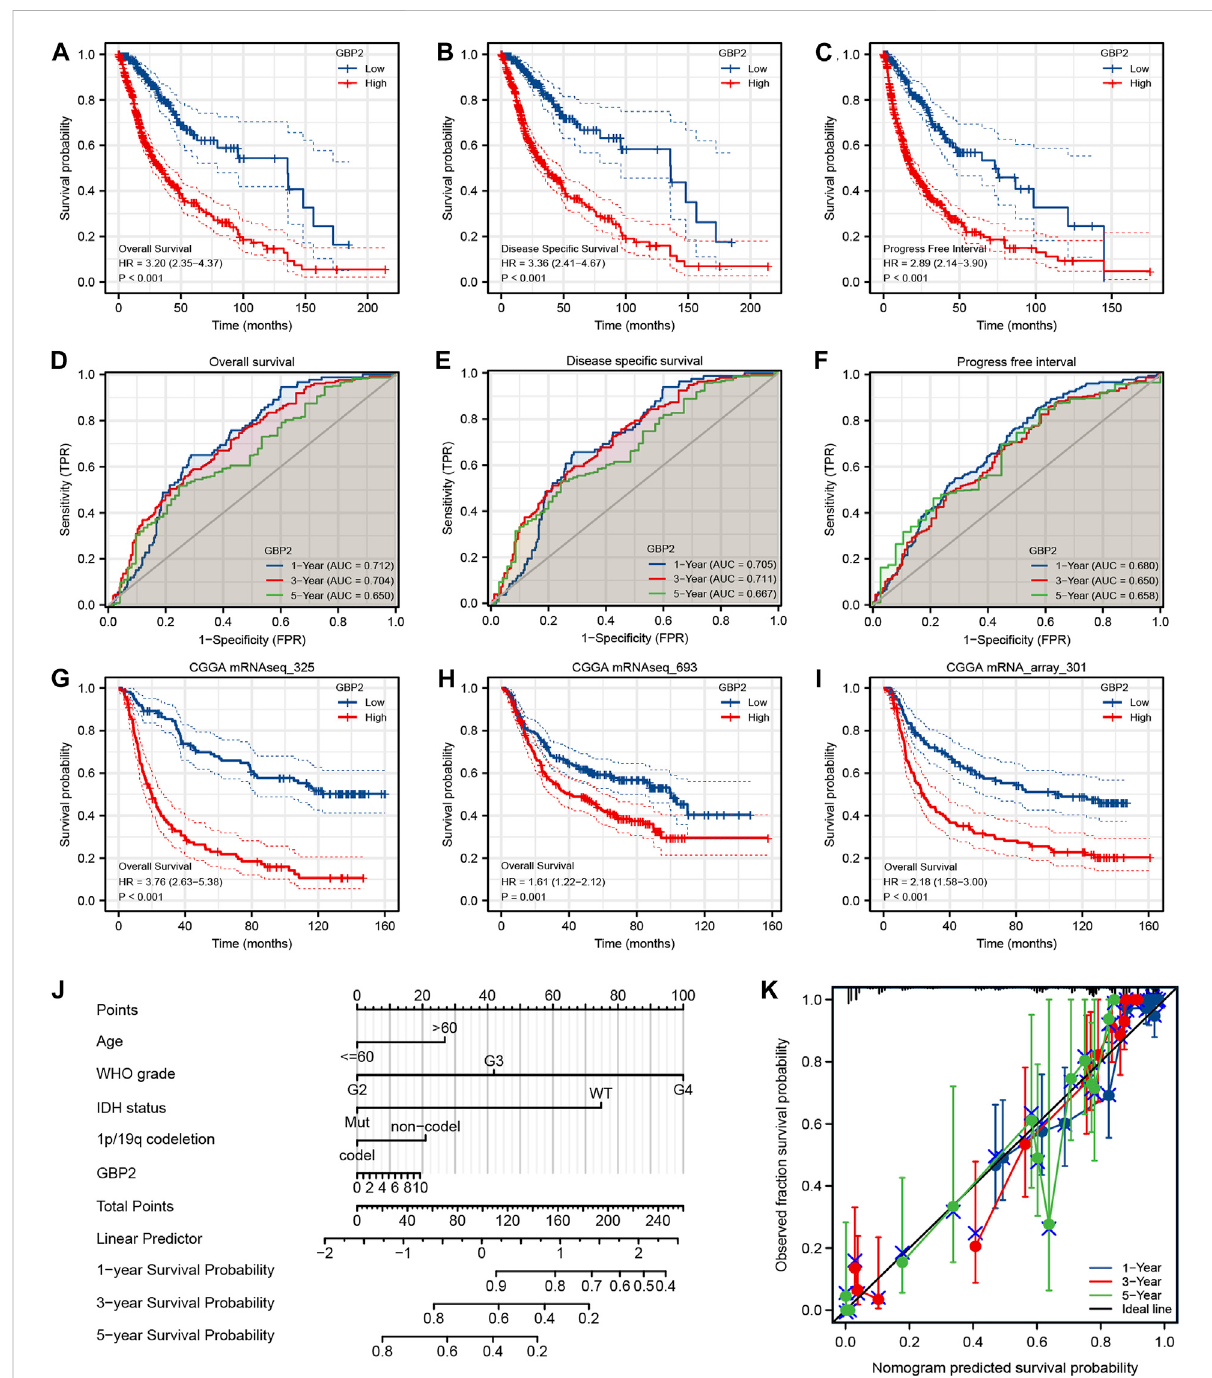
FIGURE 3 Analysis of the prognostic value of GBP2 using multiple databases. Kaplan-Meier survival analysis for OS (A) , DSS (B) and PFI (C) in glioma patientsfromtheTCGAdatabase.Time-dependentROCcurvesofGBP2expressionforOS (D) ,DSS (E) andPFI (F)